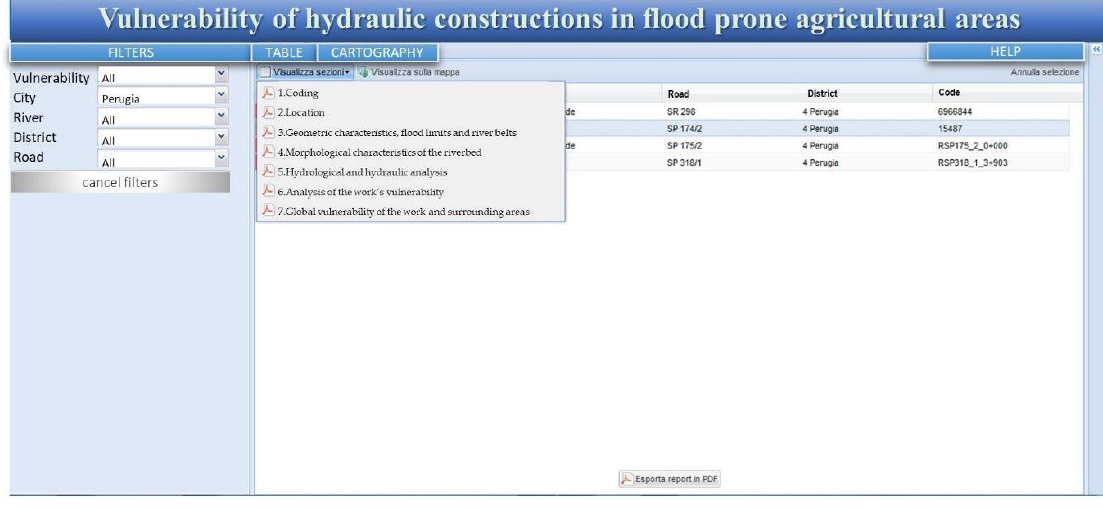
Figure 13. Tabular view with the option of downloading all the sections of the sheet.